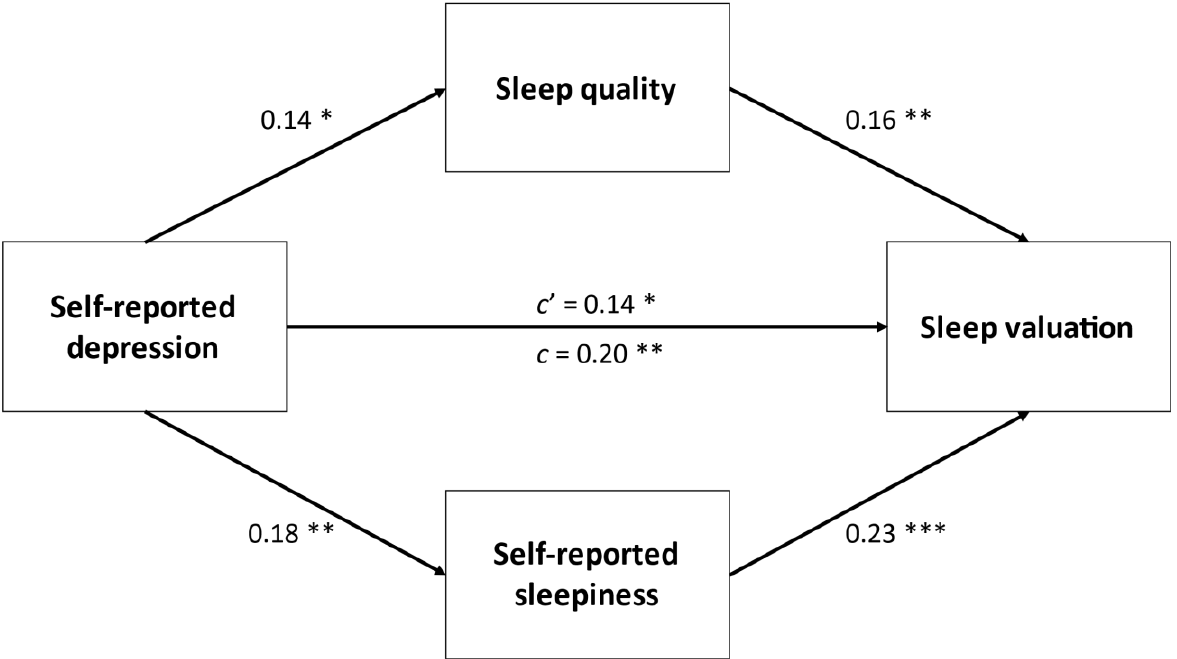
Figure 1. Parallel mediation between self-reported depression and sleep valuation. Values are standardized β . * p < 0.05, ** p < 0.01, *** p < 0.001.